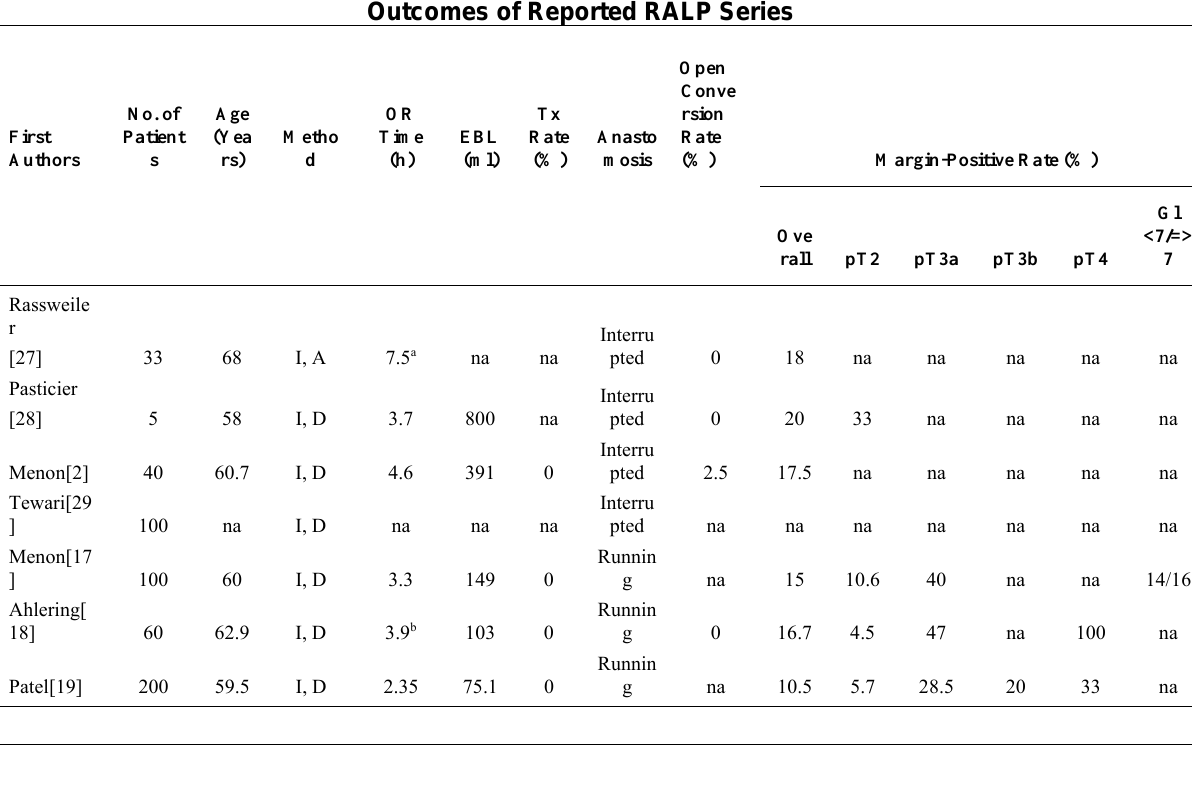
Outcomes of Reported RALP